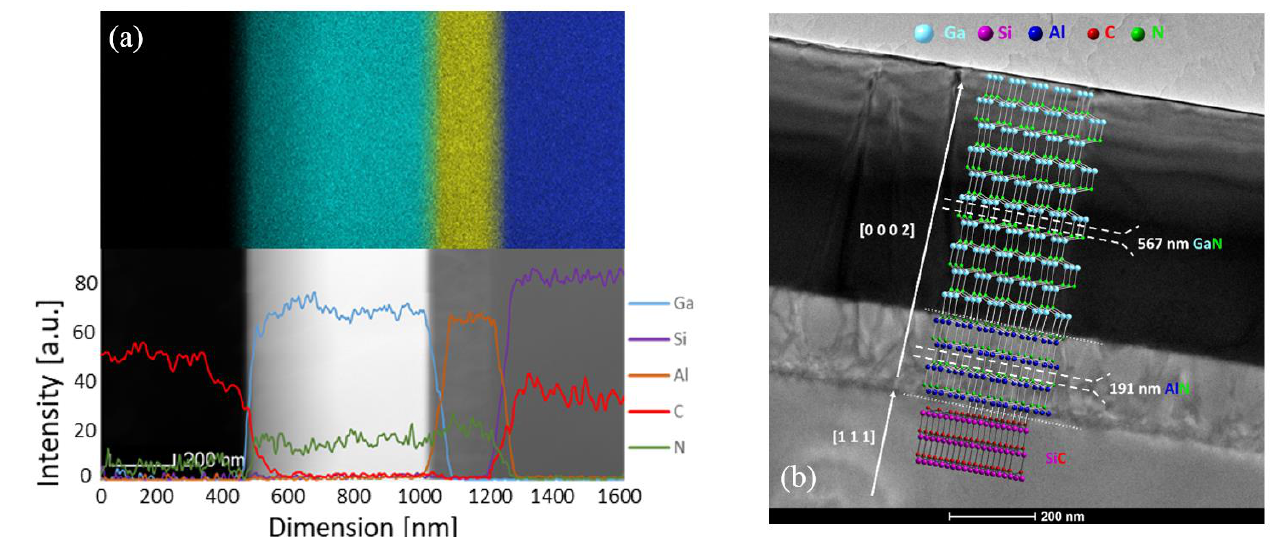
Figure 3. ( a ) STEM with EDS elemental mapping and line profile; ( b ) SiC/AlN/GaN sample overview with simulated crystal lattices.